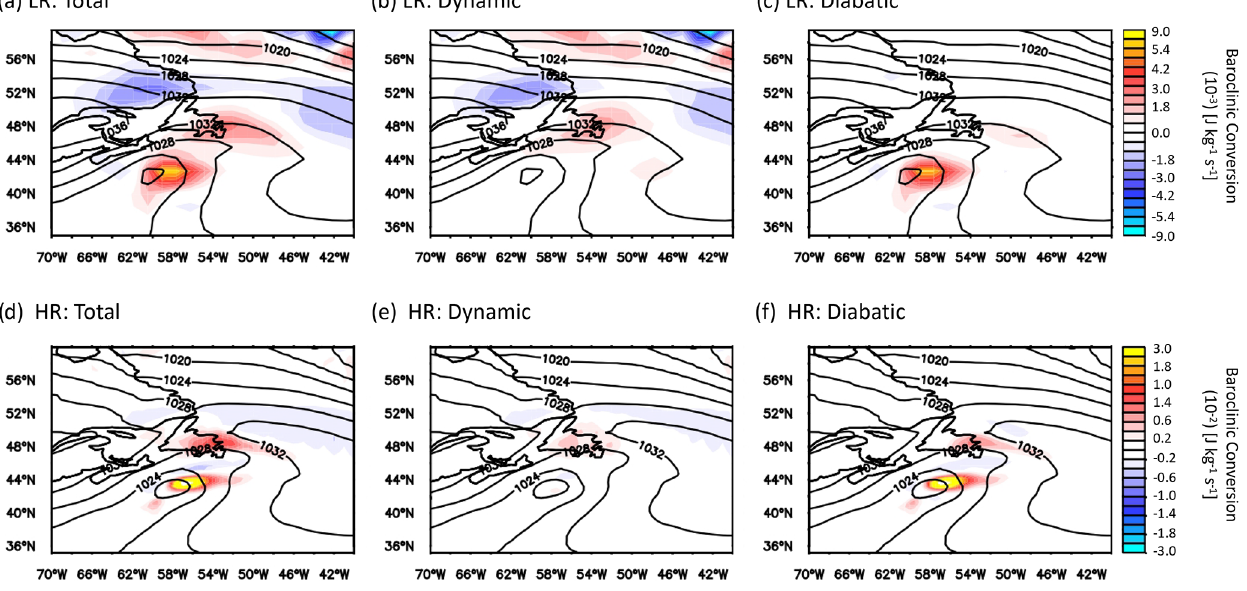
Figure 4. Vertically averaged baroclinic conversion between 850 and 300hPa (shaded) and mean sea level pressure (contoured) at 18:00UTC 29 September 2016 ( T + 18h from hindcast initiation at 00:00UTC 29 September 2016) for ARPEGE hindcasts. (a–c) ARPEGE-LR hindcast and (d–f) ARPEGE-HR hindcast. (a, d) Total (dynamic plus diabatic) baroclinic conversion, (b, e) baroclinic conversion from dynamical processes, and (c, f) baroclinic conversion from diabatic processes. The colour scales refer to each